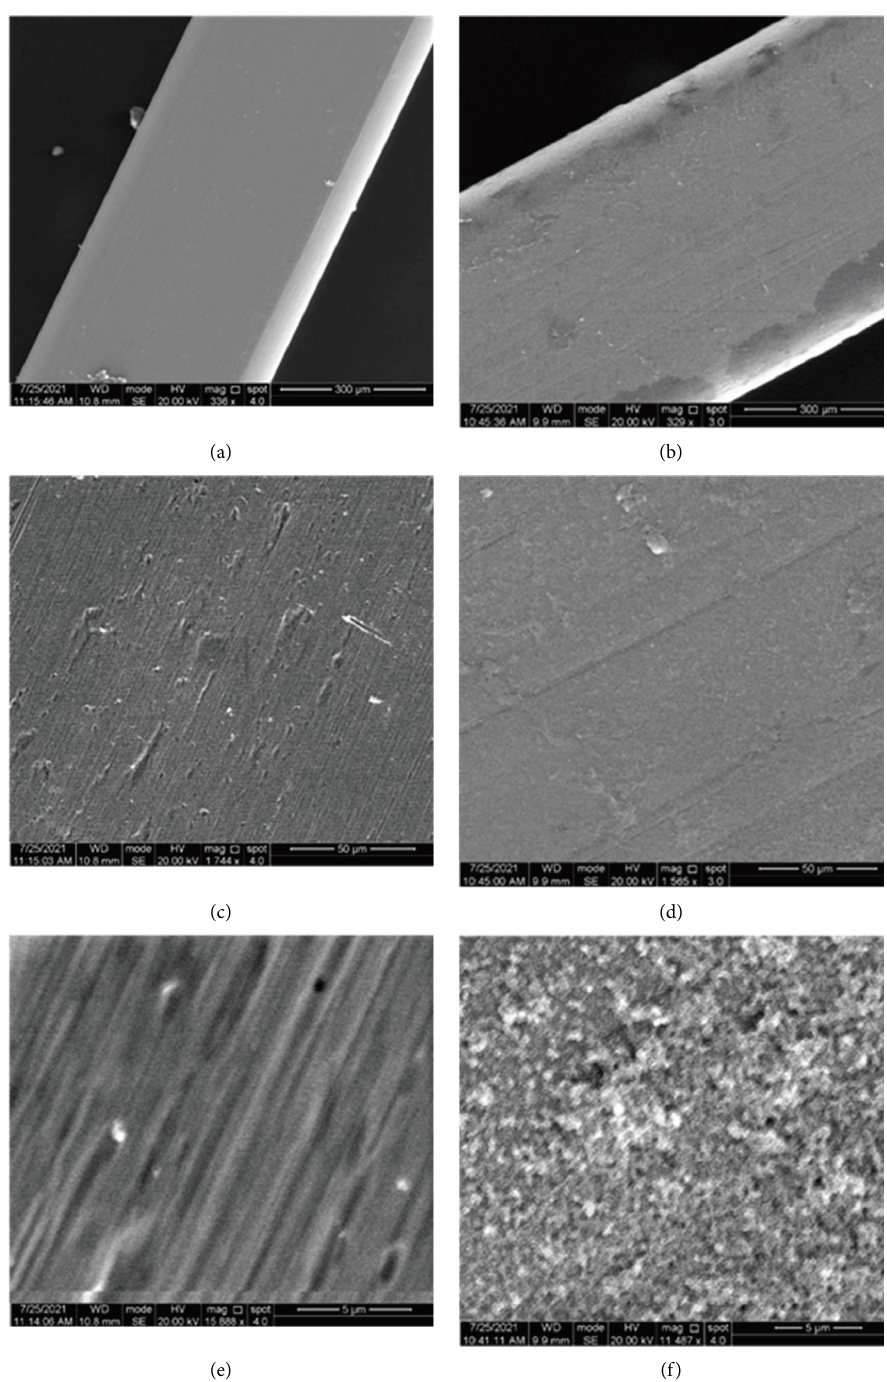
Figure 5: SEM images for the examined SSW at diferent magnifcation powers. (a, c, e) uncoated and (b, d, f)